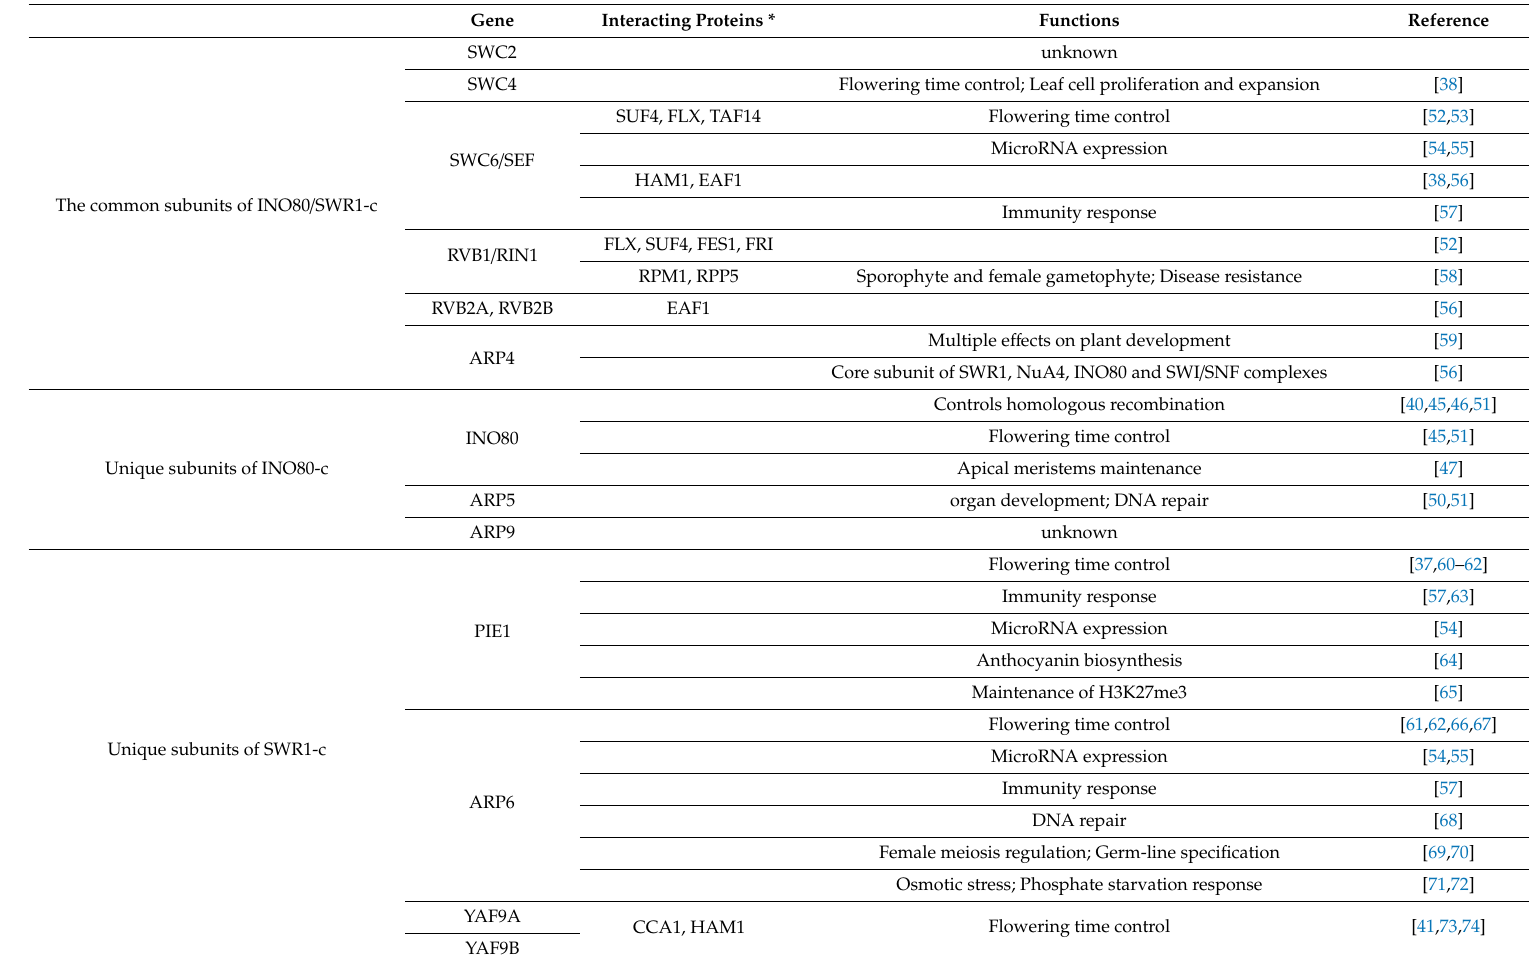
Table 2. The Functions of core SWR1 / INO80-c Subunits in